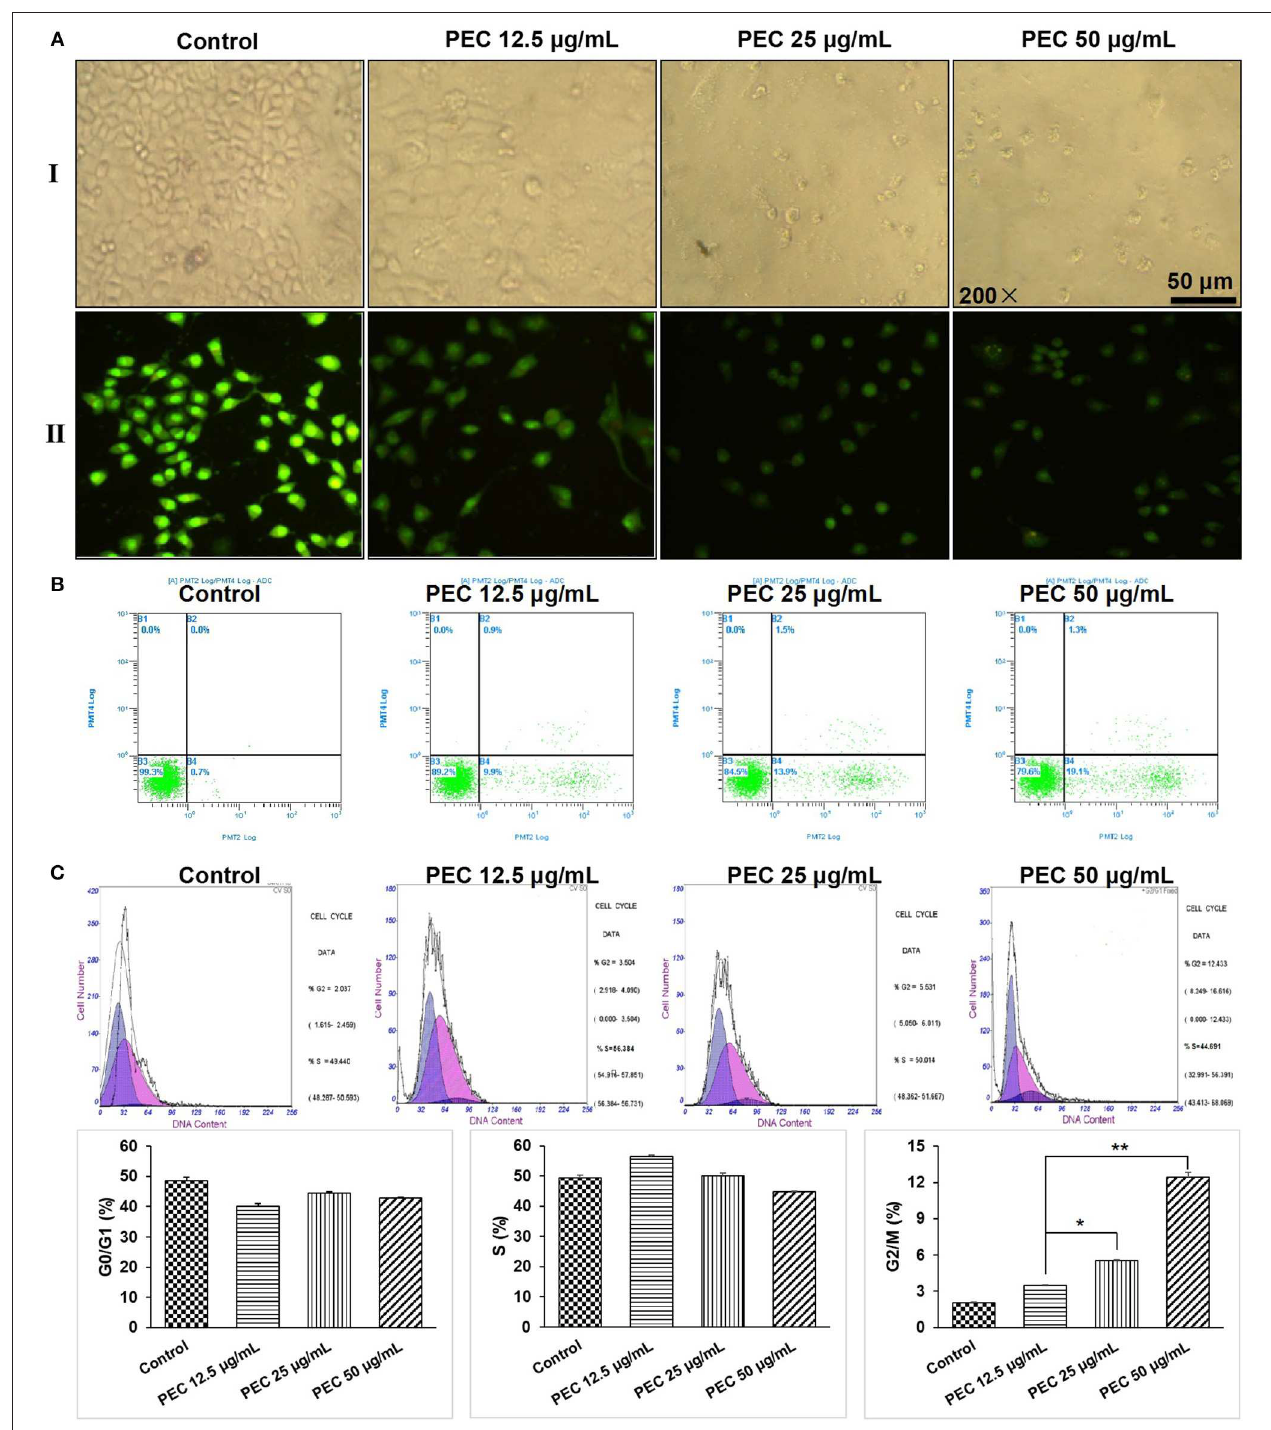
FIGURE 3 | Effects of PEC on the morphology of SGC-7901 cells in (AI) the inverted microscope and (AII) the fluorescent microscope. (B) Detection of apoptosis of SGC-7901 induced by PEC in FCM. (C) Effect of PEC on SGC-7901 in Periodic Blockade. Compared with control group: * P < 0.05, ** P < 0.01.